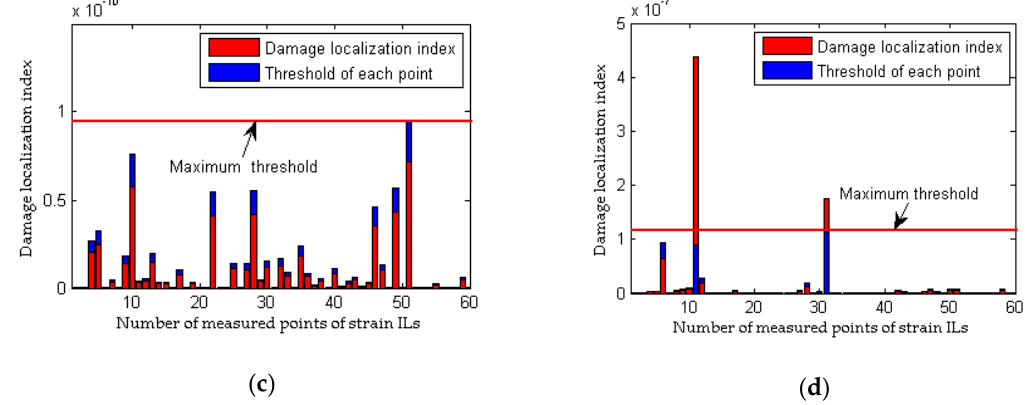
Figure 13. Results of the proposed method considering the effects of loading conditions: ( a ) results of the proposed method for case 8 without noise; ( b ) results of the proposed method for case 8 with 0.1% noise level; ( c ) results of the proposed method for case 8 with 1.0% noise level; ( d ) results of the proposed method for case 9 with 2.5% noise level.